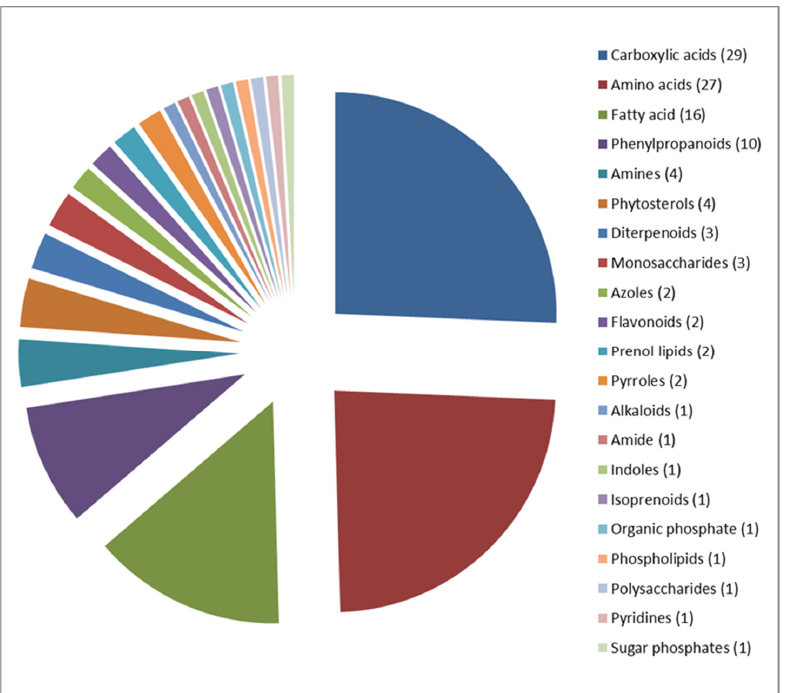
Figure 2. Classification of 113 metabolites identified in the grains of Mappillai Samba and CBMAS 14065 into 21 different metabolite classes. The number in parentheses indicates the number of metabolites mapped against each metabolite class.